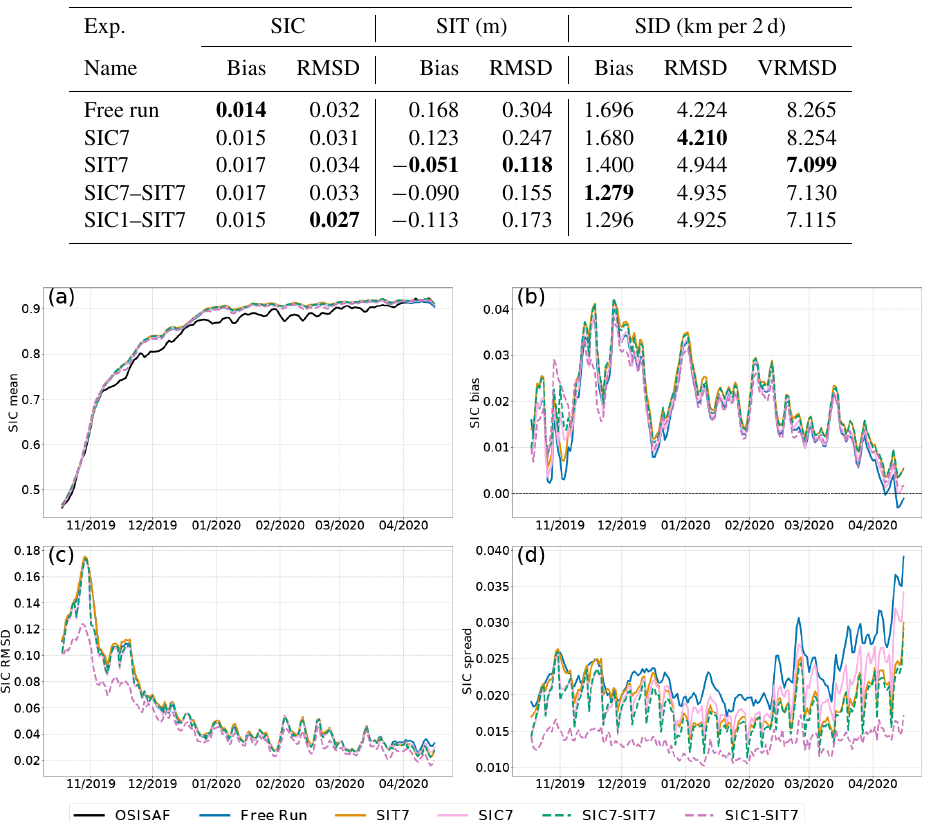
Figure 2. Time series of spatially averaged SIC from the model forecast against OSI-SAF SIC from 18 October 2019 to 16 April 2020. (a) Ensemble mean SIC; (b) bias; (c) RMSD; (d) ensemble spread (standard